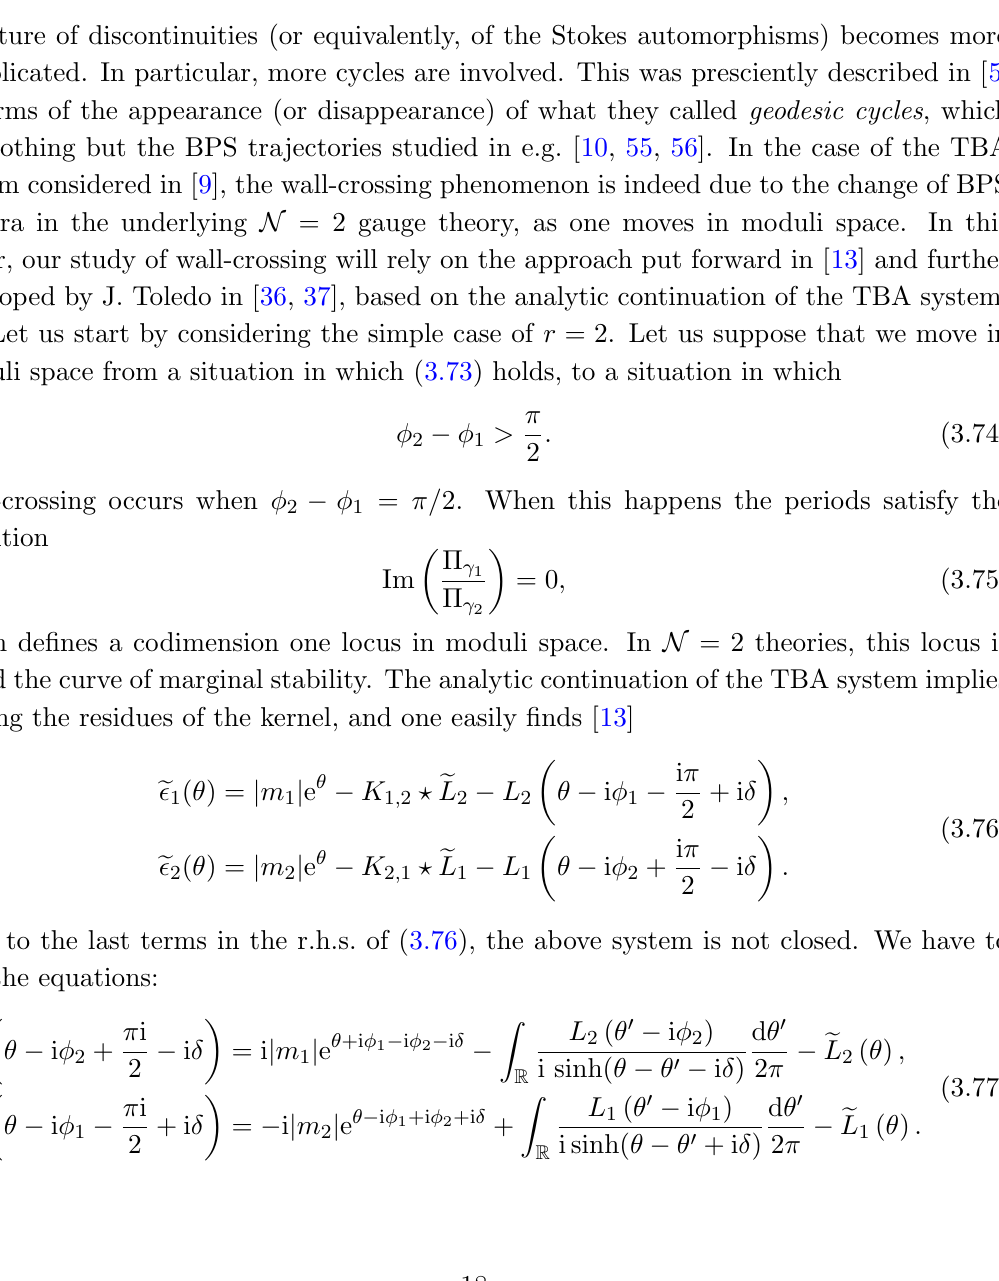
Figure 4 . As we move in moduli space away from the \minimal" chamber, new cycles intervene in the TBA equations, and correspondingly, in the discontinuity equations. The (cid:12)gure shows the situation for r = 2. In the minimal chamber only the cycles (cid:13) 1 , (cid:13) 2 are involved, but as they rotate in the complex plane, wall-crossing occurs and one has to consider as well the cycle (cid:13) 12 = (cid:13) 1 + (cid:13) 2